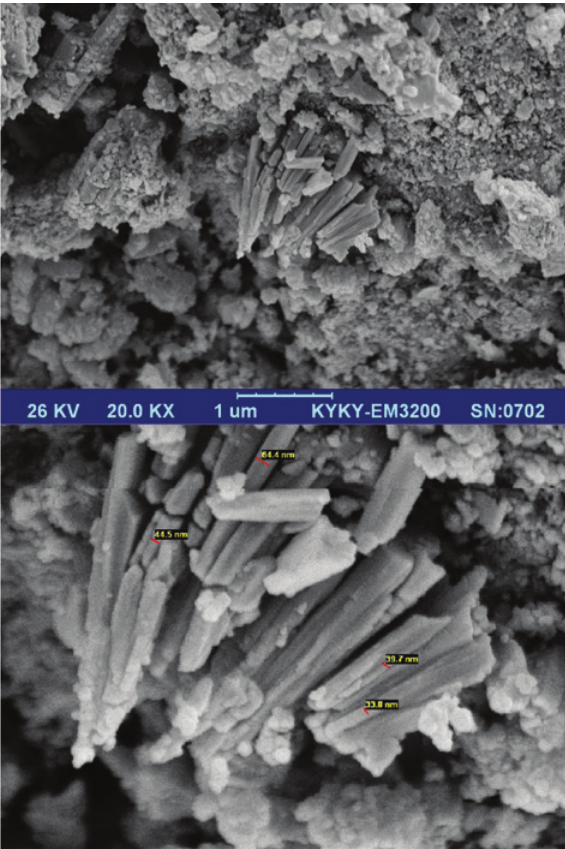
Figure 4: The SEM images of the PbFe without any